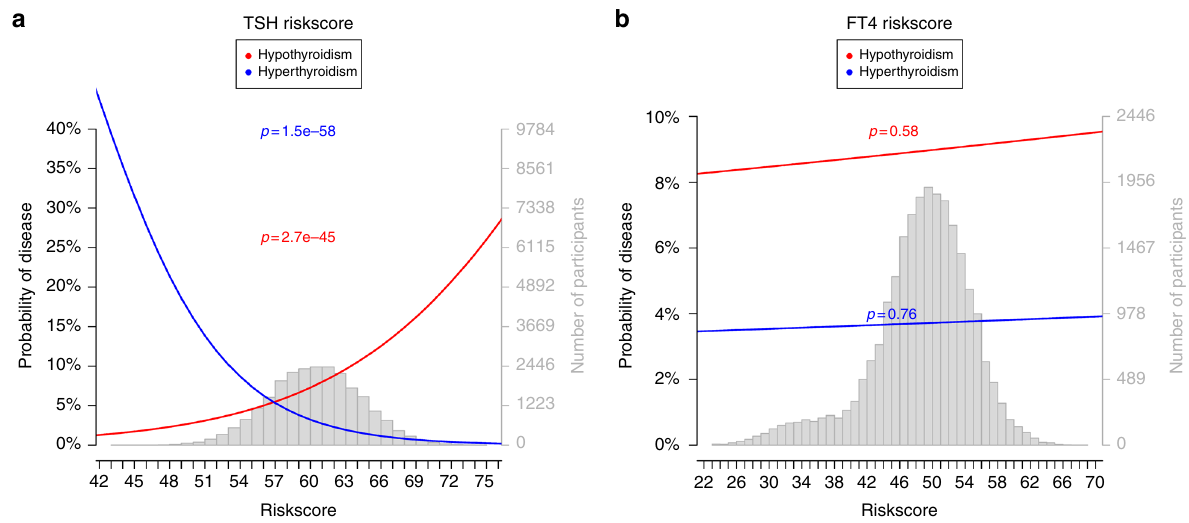
Fig. 5 Associations of genetic risk scores with hypothyroidism and hyperthyroidism. The y axis shows the probability of hypothyroidism (red) or hyperthyroidism (blue) with the p -value of the association test of the trait on the risk score. The x axis shows the percentage of risk alleles carried based on a weighted genetic risk score (GRS) built using the 61 TSH-associated ( a ) and 31 FT4-associated GWAS SNPs ( b ). The gray histogram shows the distribution of the GRS in the study characterized a new thyroid hormone transporter as well as a new thyroid hormone metabolizing enzyme.